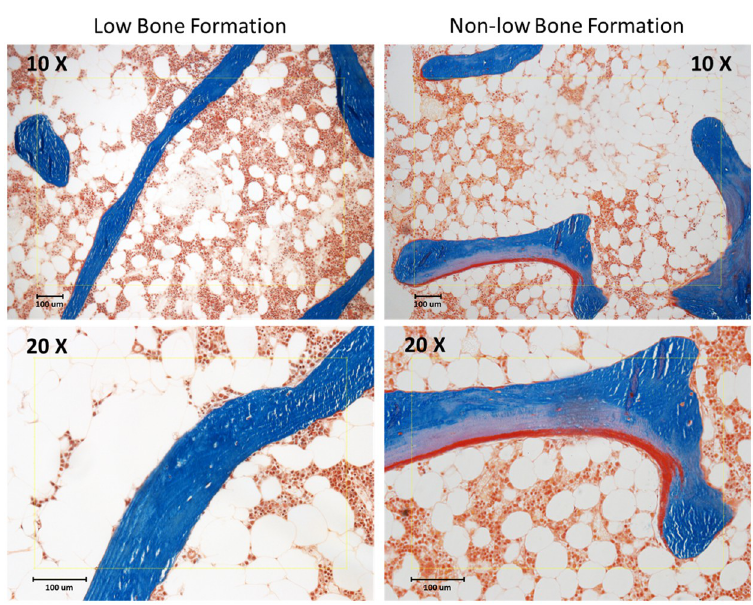
Fig 2. Example of low and non-low bone formation under bright field light microscopy. Microphotographs of undecalcified section of cancellous bone from human anterior iliac crest. Section thickness 4 μ m. Masson Goldner Stain. Calcified bone stained blue, osteoid red. Left panel: Low bone formation: decreased trabecular bone volume, increased trabecular separation. No surface resorption or osteoid deposition. Right panel: Non-low bone formation: decreased trabecular bone volume, increased trabecular separation, thin osteoid seams, increased trabecular surface resorption.